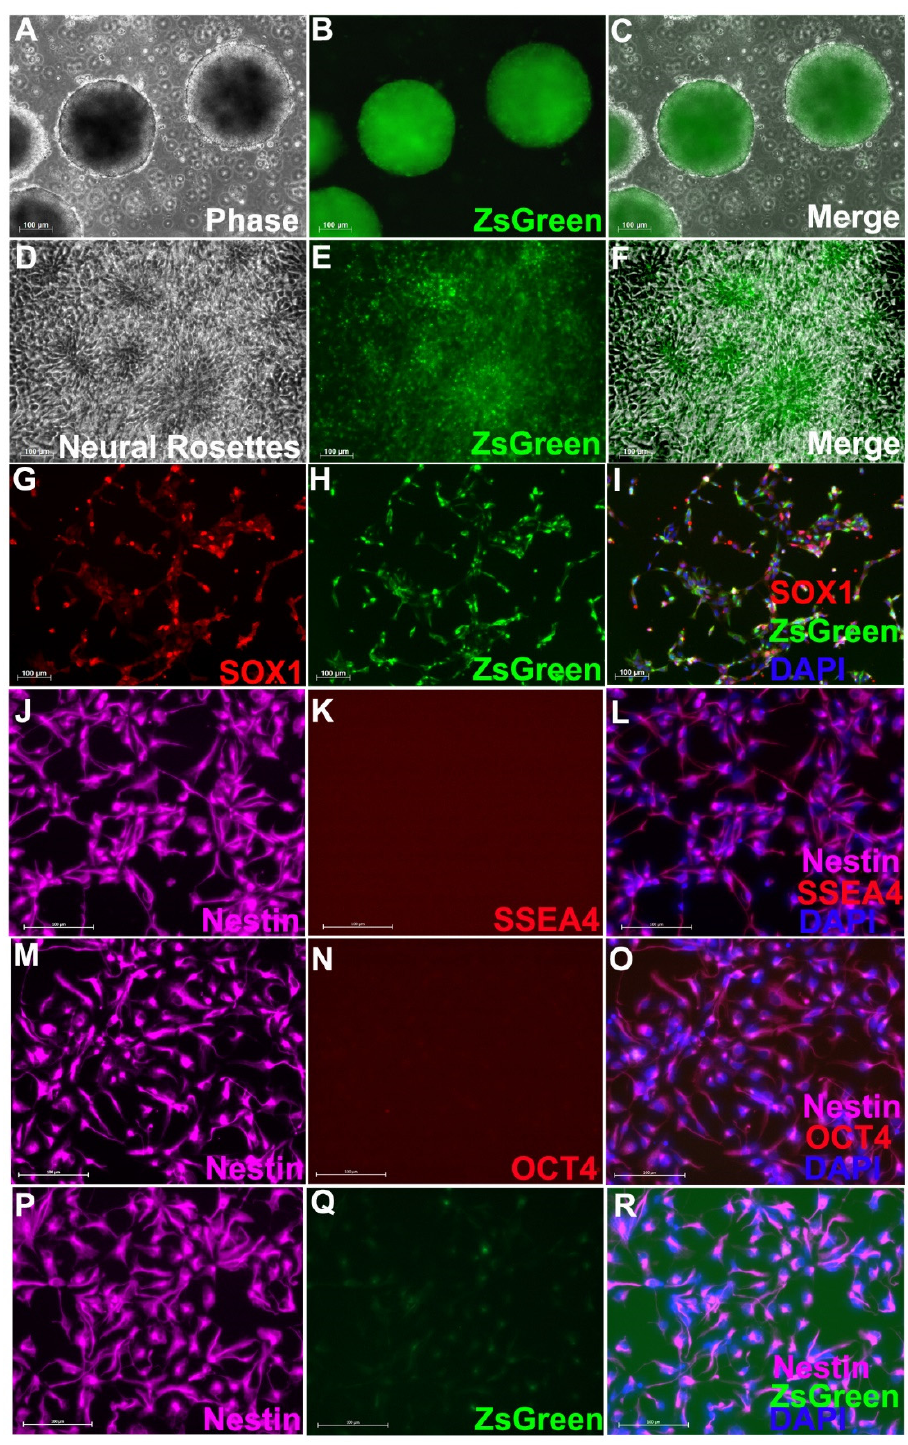
Figure 1. Neural differentiation of Nestin-ZsGreen hiPSC knockin cell line. After 12 days of neural induction as embryoid bodies (EB), cells started to express Nestin-ZsGreen ( A – C ). When dissociated and replated, they formed a typical neural rosette structure, while continuing to express ZsGreen ( D – F ). After FACS for ZsGreen, almost all GFP+ cells expressed SOX1, a well-accepted and specific neural stem cell marker ( G – I ). The purified NPCs do not contain undifferentiated iPSCs as evidenced by lack of expression of SSEA4 ( J – L ) and OCT4 ( M – O ), two commonly used pluripotency markers. Before being grafted to animals, expression of ZsGreen ( P – R ) was significantly downregulated although Nestin continued to be expressed ubiquitously. Scale Bar: 100